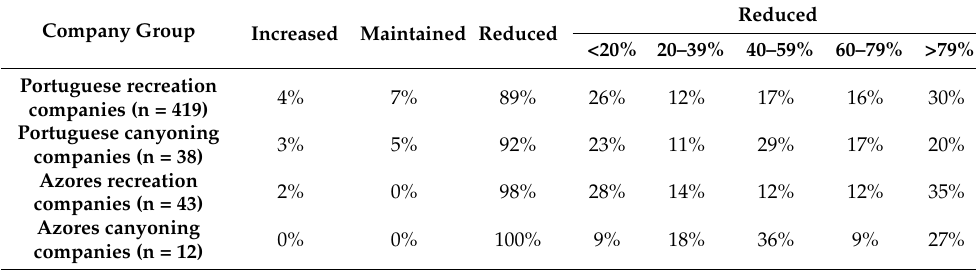
Table 2. Turnover variations in the third quarter of 2020.